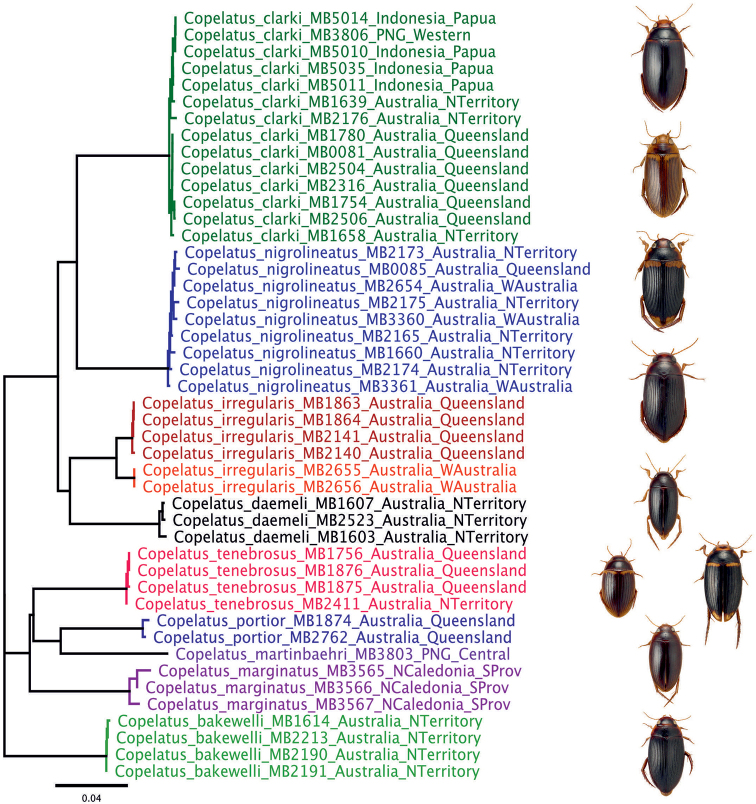
Maximum likelihood tree for Australian Copelatus. Neighbour joining tree (p-distances) calculated with Geneious (11.0.4.) software.